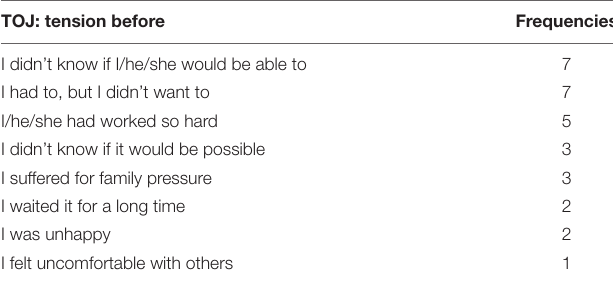
TABLE 3 | Frequencies of coded category “Tension before tears of